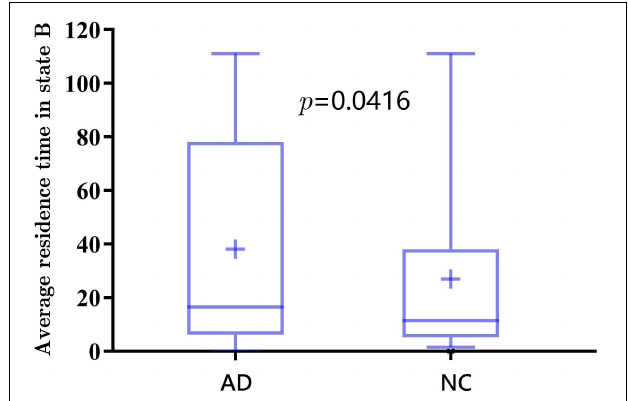
FIGURE 7 | The average residence time of spatiotemporal AAL networks for AD and NC.